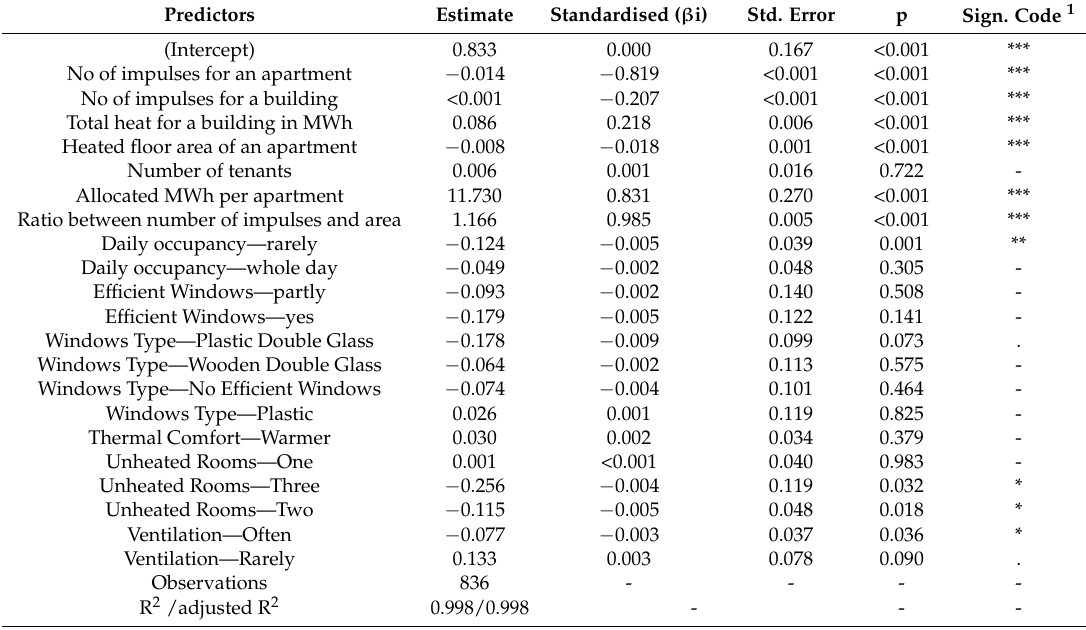
Table 5. Summary statistic of quantitative data in the analysed